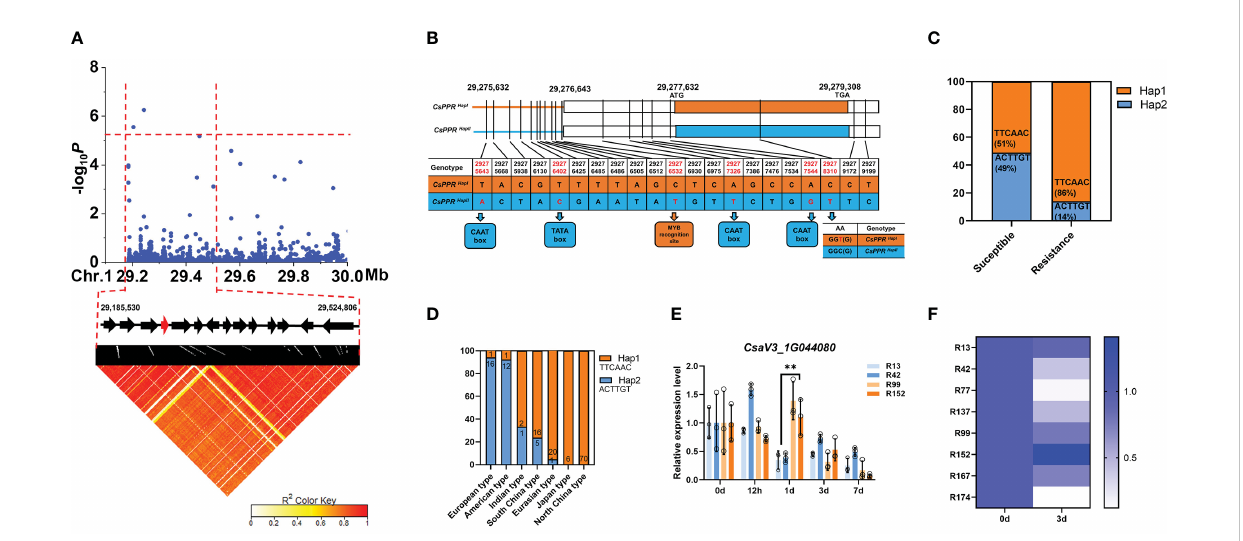
FIGURE 8 Identi fi cation of cucumber LT germination trait-associated gene CsaV3_1G044080 ( CsPPR ). (A) Local Manhattan plot (top) and LD heatmap (bottom) surrounding the peak on chromosome 1. The dashed line indicates the signi fi cance threshold (-log 10 ( P )=5.0). Dashed lines indicate the candidate region (~ 339 kb) for the peak. Fourteen functionally annotated genes were predicted in the gLTG1.2 candidate region. The arrows represent the direction of the genes. Function of red arrow gene is relative to abiotic stress. (B) Schematic representation of two haplotypes of CsPPR . Orange and blue box represent promoter elements. (C) Orange represents the proportion of accessions that are Hap1 (TTCAAC) while blue represents the proportion that are Hap2 (ACTTGT) among the susceptible and resistant lines genotype. Orange represents the genotype Hap1 proportion in susceptible or resistant lines. Blue represents the genotype Hap2 proportion in susceptible or resistant lines. (D) The percentage of Hap1 and Hap2 genotypes within each ecotype. (E) Relative expression level of CsaV3_1G044080 in LT sensitive lines ( ‘ R13 ’ , ‘ R42 ’ ) and LT resistant lines ( ‘ R99 ’ , ‘ R152 ’ ) after LT treatment (0 d, 12 h, 1 d, 2 d, 3 d and 7 d), tested through qRT – PCR. Actin was used an internal control. Data are represented as average values with SD of three independent biological replicates. (F) The heatmap indicates relative expression level of CsaV3_1G044080 in LT sensitive lines ( ‘ R13 ’ , ‘ R42 ’ , ‘ R77 ’ , ‘ R137 ’ ) and LT resistant lines ( ‘ R99 ’ , ‘ R152 ’ , ‘ R167 ’ , ‘ R174 ’ ) after LT treatment (0 d and 3 d), tested through qRT – PCR. Actin was used an internal control. **Signi fi cant difference (P